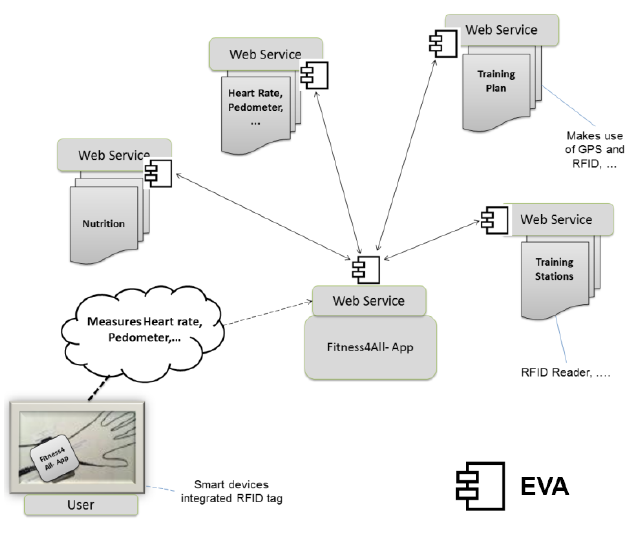
Figure 2. The service co-evolution with EVAs in the